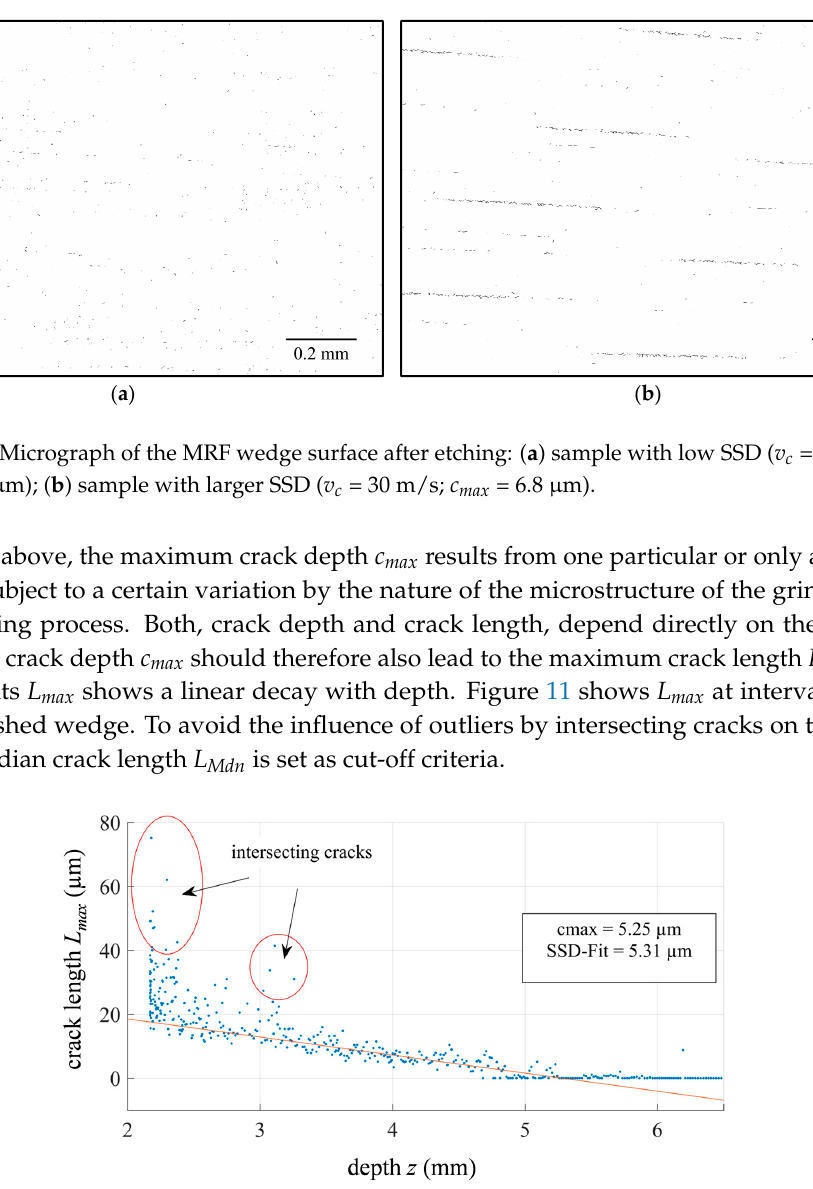
Figure 11. Maximum crack lengths L max as a function of depth ( v c = 54 m/s) with linear fit.